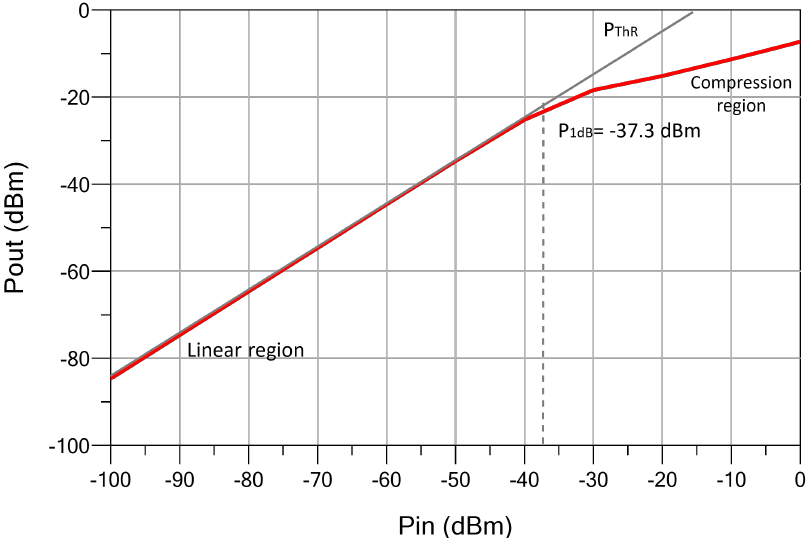
Figure 11. Simulation of 1-dB compression point for